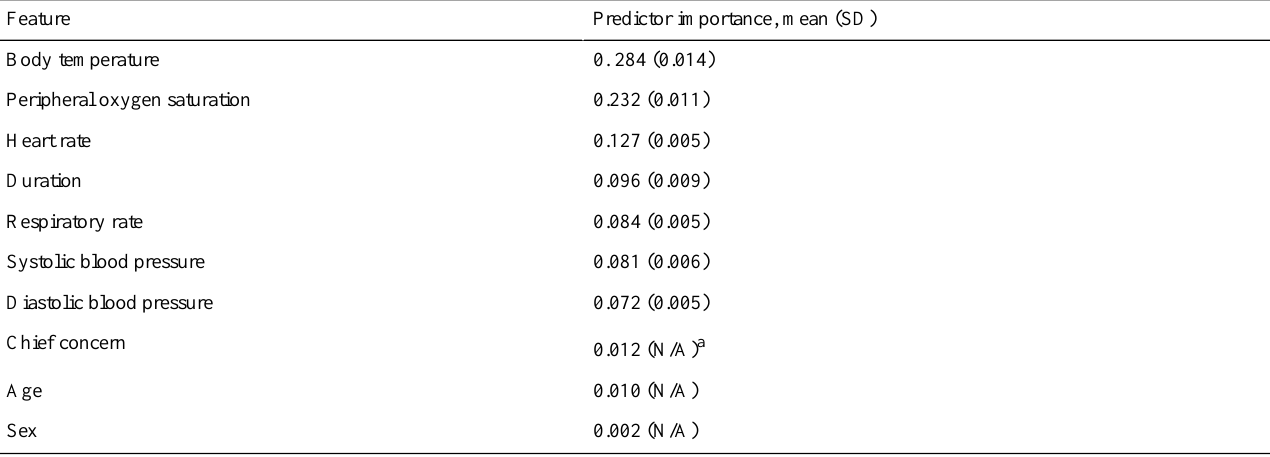
Table 5. Predictor importance in the random forest model with 10% balancing.